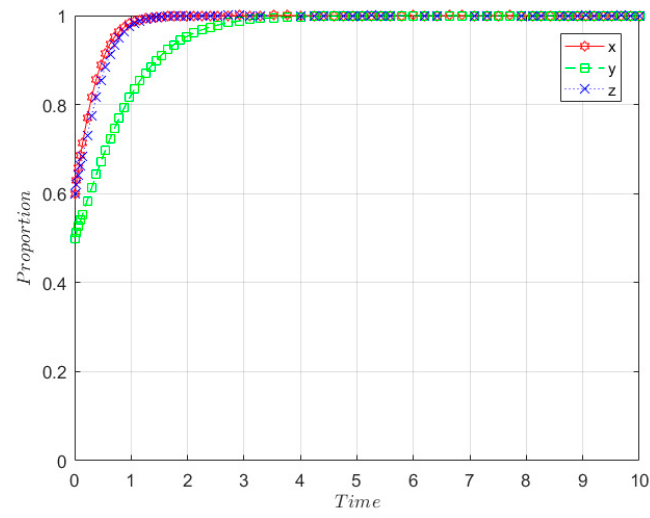
Figure 4. Evolution path of stability point E 8 (1, 1, 1) in the middle development stage.